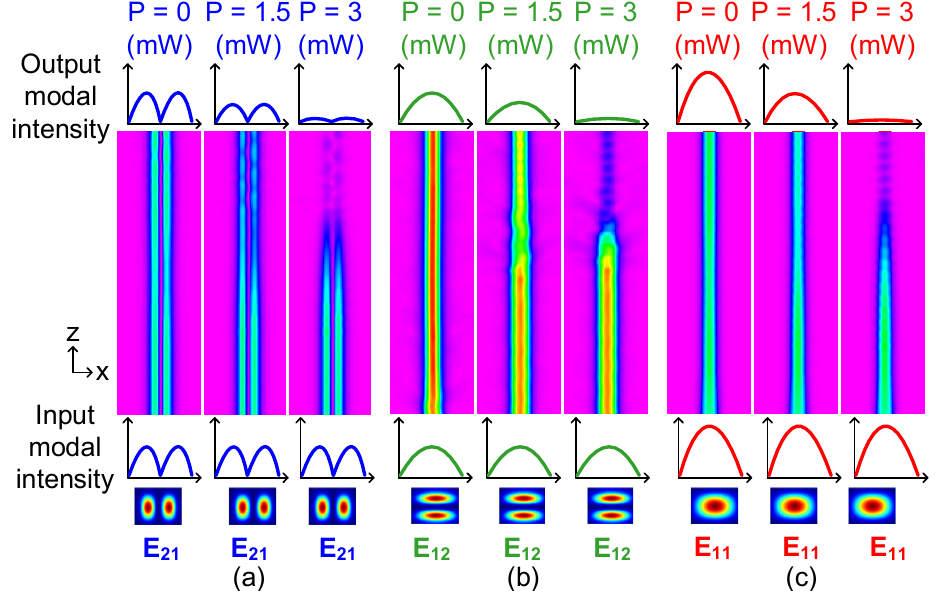
Figure 7. The propagation path for ( a ) the E 21, ( b ) the E 12 and ( c ) the E 11 modes with different electric power applied to the GEHs.